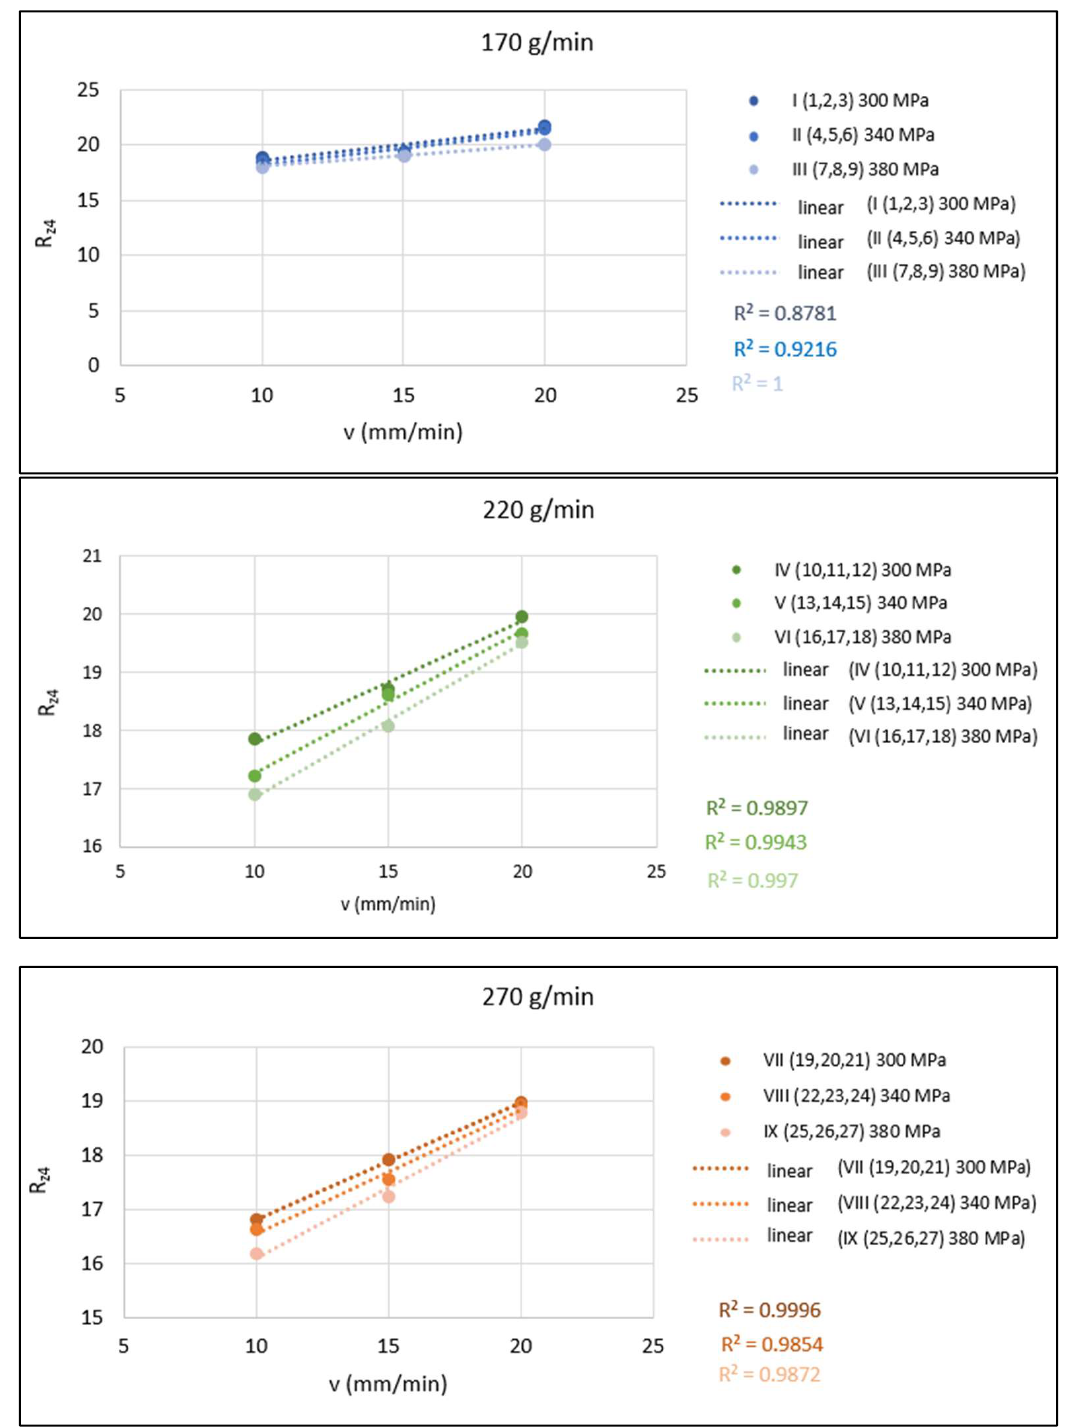
Figure 9. Graphical evaluation of 1-parametric dependencies of Rz 4 = f( v ) for m A = 170, 220 and 270 g/min.